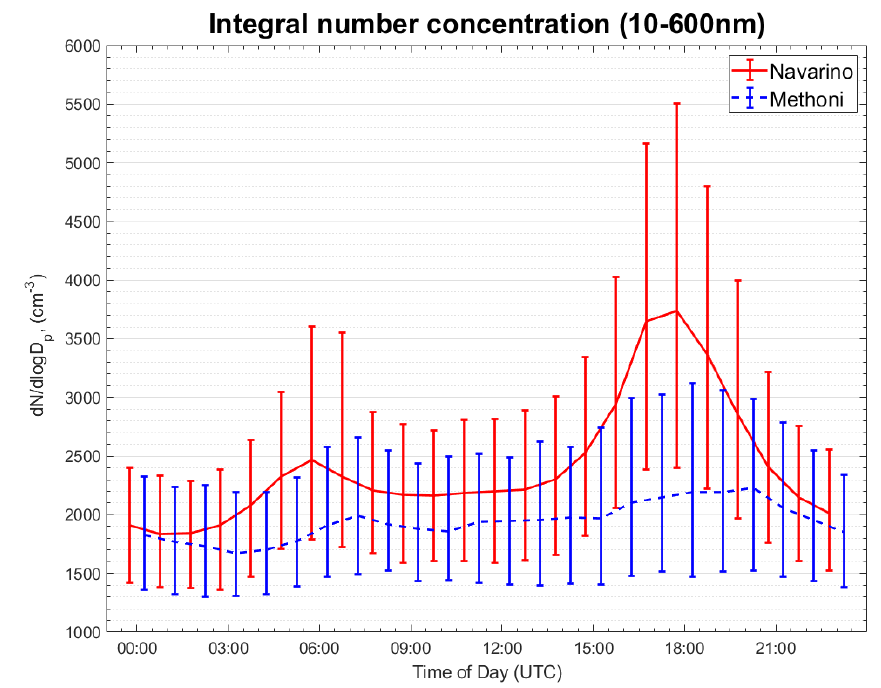
Figure 7. The diurnal variation of the total particle number concentrations at Navarino (observations for the period April 2011–September 2013) and at Methoni (observations for the period November 2013–December 2016). The lines indicate the median values while the error bars indicate the inter- quartile range.